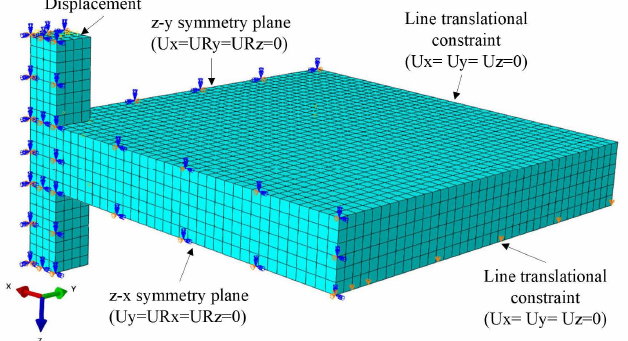
Figure 5. FE model for Specimen SB1.